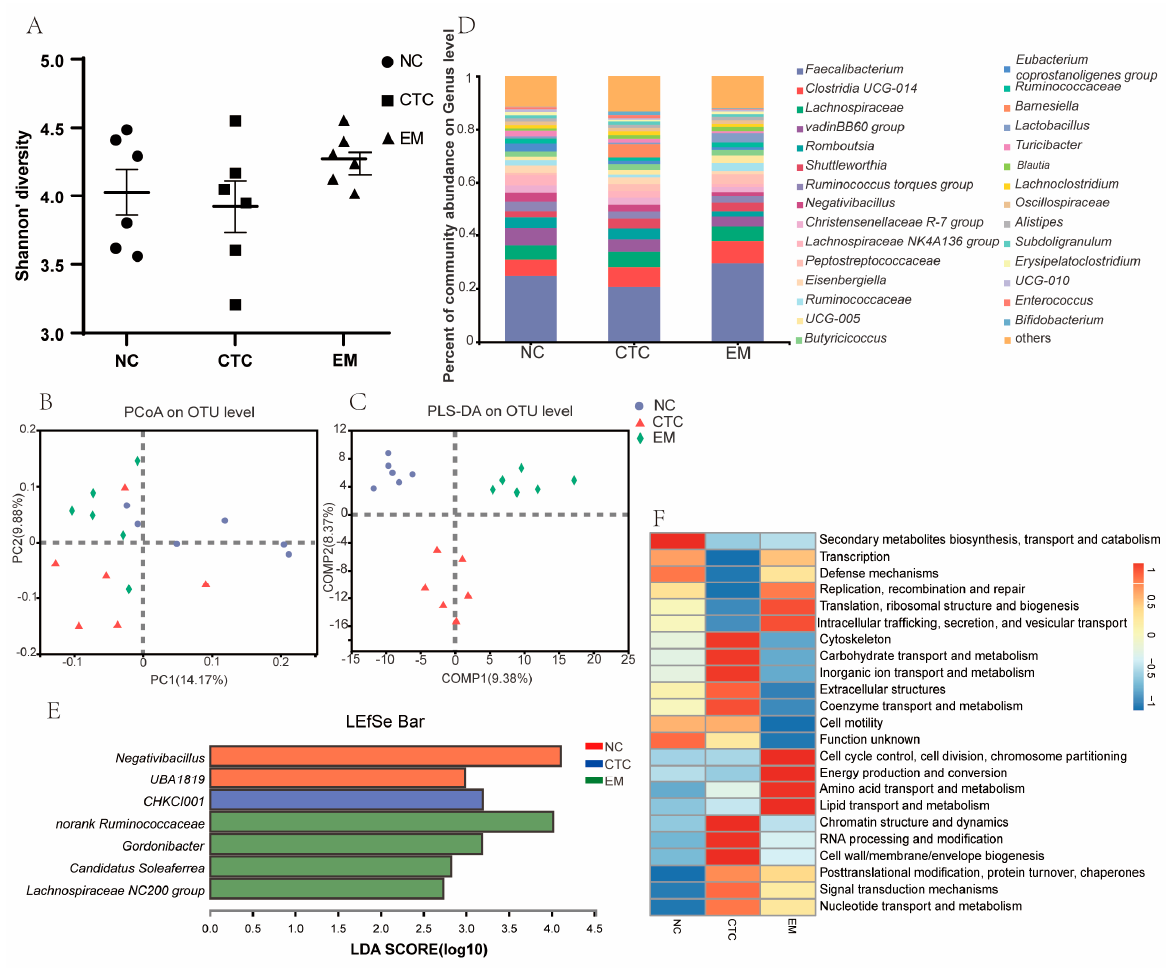
Figure 5. Summary of microbiota composition in the cecal contents of broilers on day 42. ( A ) Shannon Index reflecting species α -diversity within groups. ( B ) Component microbial β -diversity compared by PCA. ( C ) PLS-DA-based comparison of samples between multiple groups and ( D ) the genus-level microbiota composition. ( E ) LDA scores generated for differentially enriched genera with limits of LDA > 2, p < 0.05. ( F ) PICRUSt2 analysis. N = 6 per treatment group.